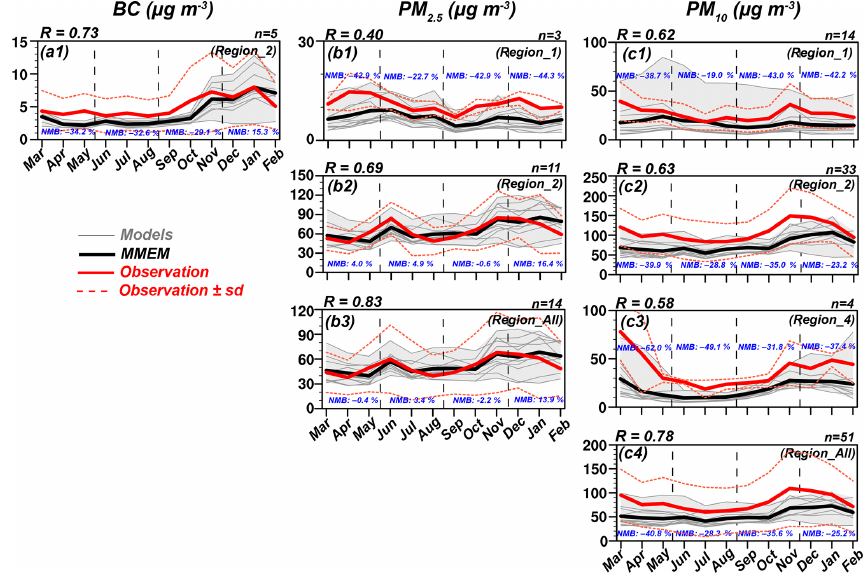
Figure 4. Time series of the monthly observed and simulated aerosol compositions: (a1) BC, (b1–b3) PM 2 . 5 , and (c1–c4) PM 10 . The thin grey lines represent simulation results, and the grey shaded areas indicate the spread. The thick black lines are the ensemble mean. The red solid lines mean the observations, and the dashed red lines represent 1 standard deviation. Correlation coefficients ( R values, shown in black) for the whole year and normalized mean biases (NMBs, shown in blue) for each season between observations and MMEM are shown in each panel. The number of monitoring sites used to calculate the statistics in each subregion is also listed above each panel. In this figure, the monthly observations except BC are taken from EANET and CNEMC; the monthly BC concentrations are collected from published